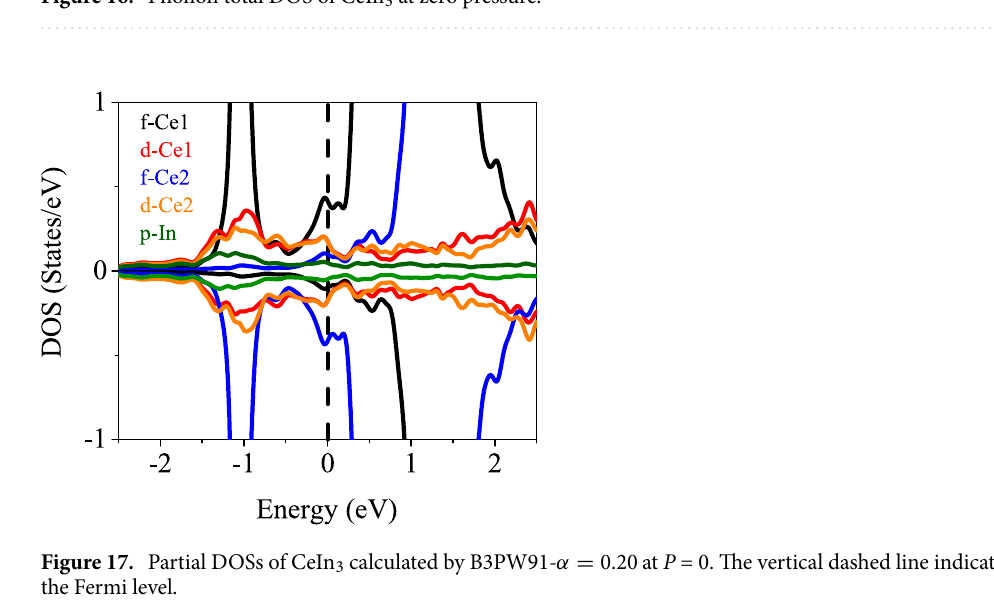
Figure 16. Phonon total DOS of CeIn 3 at zero pressure.